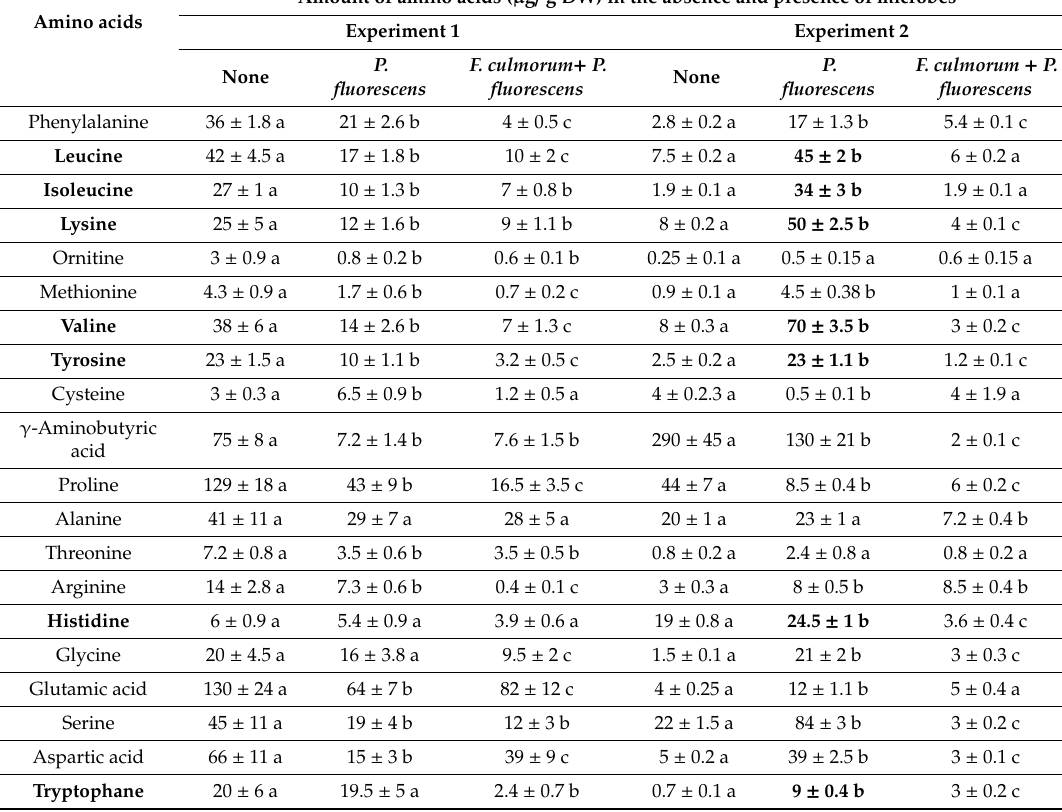
Table 5. The amount of amino acids in exudates of control barley, barley colonized by P. fluorescens and barley jointly colonized by F. culmorum and P. fluorescens collected in the two experiments. Amino